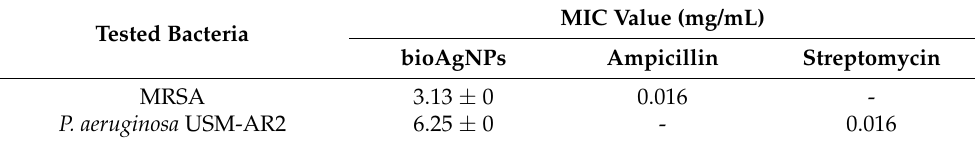
Figure 4. Observation of color changes using TEMA of bioAgNPs and commercial antibiotics against MRSA ( A ) and P. aeruginosa USM-AR2 ( B ). The MIC value is denoted as the lowest concentration of the tested samples. Lines 1–3 show the experiment performed in triplicate on the bioAgNPs. Line 4 shows the commercial antibiotics used (ampicillin and streptomycin). Line 5 shows the negative control. Table 1. MIC values for the bioAgNPs and antibiotics against MRSA and P. aeruginosa USM-AR2. Tested